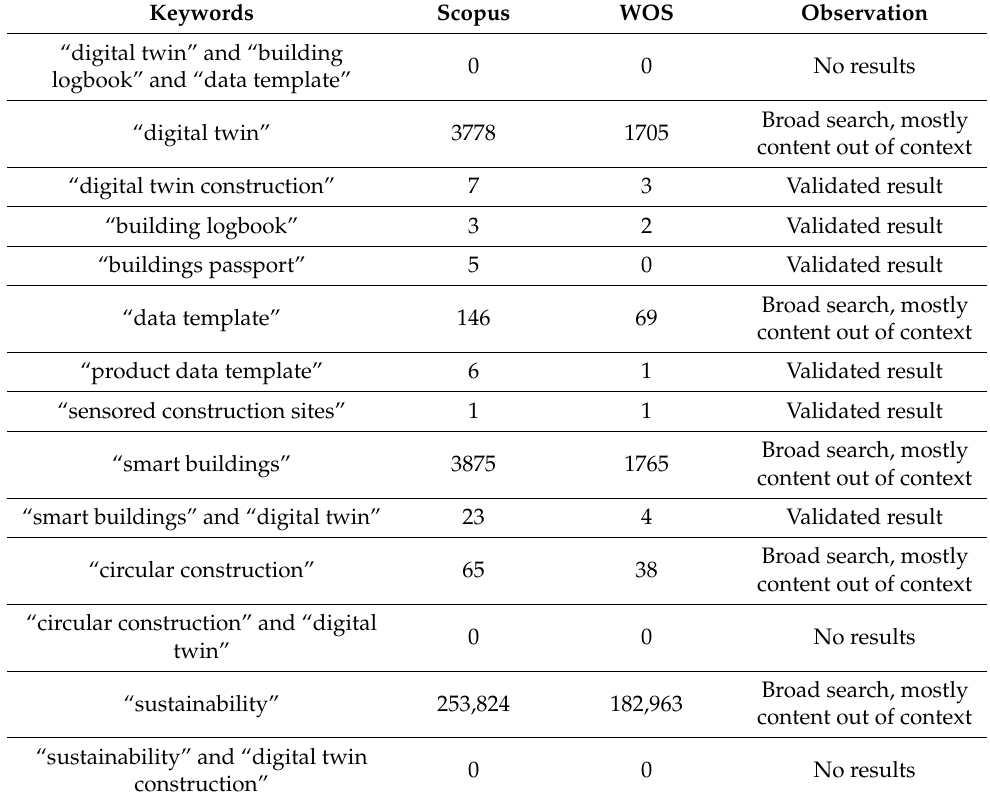
Table 1. Keywords combination to the literature